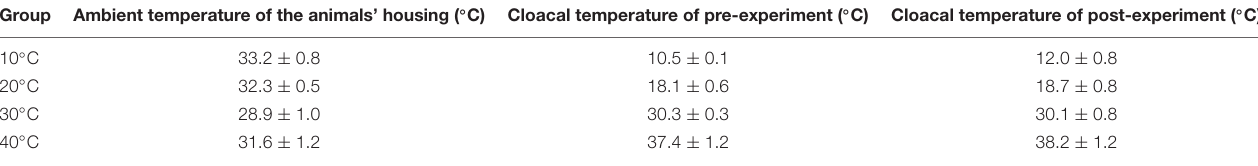
TABLE 2 | Changes in the cloacal temperature of Trachemys scripta elegans in pre- and post-electrophysiological experiments. Group Ambient temperature of the animals’ housing ( ◦ C) Cloacal temperature of pre-experiment ( ◦ C) Cloacal temperature of post-experiment ( ◦